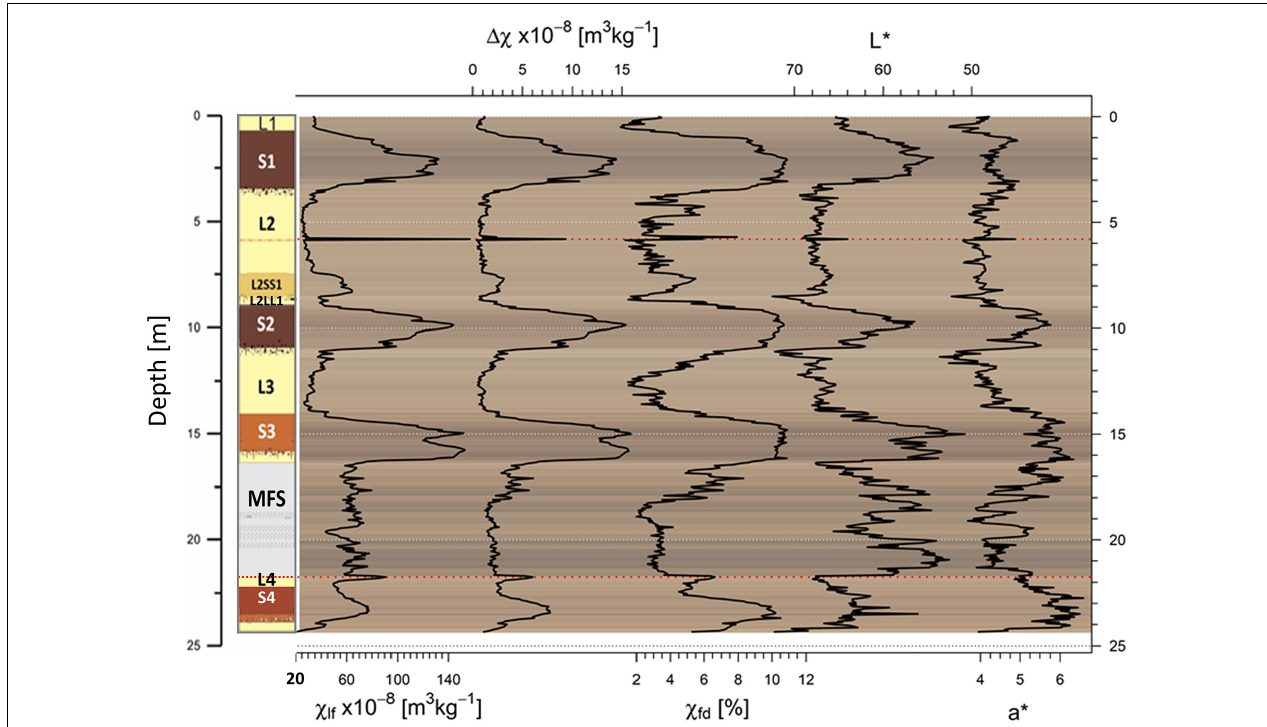
FIGURE 3 | Stratigraphic view of magnetic susceptibility parameters χ lf , (cid:49) χ , χ fd [%], and selected colorimetric parameters L* and a*. The variability of magnetic susceptibility parameters with depth reflects the pacing of interglacial (S4–S1) and glacial (L4–L1) cycles. Potential tephra layers (red dotted lines) are referred to as the L2 tephra and to as the Bag tephra. Note that the scale for L* is inversed. Lab color values are transformed to RGB colors for each sample and plotted in the background.